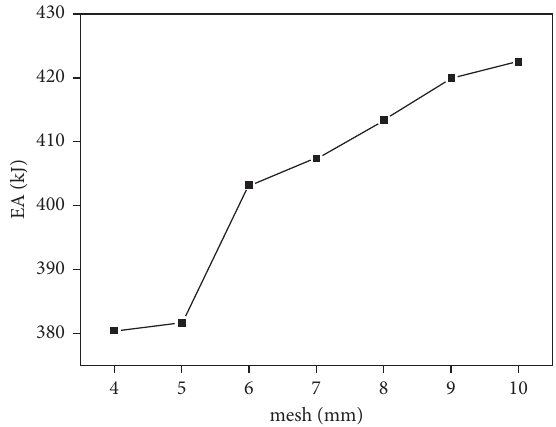
Figure 5: Influence of element size on EA